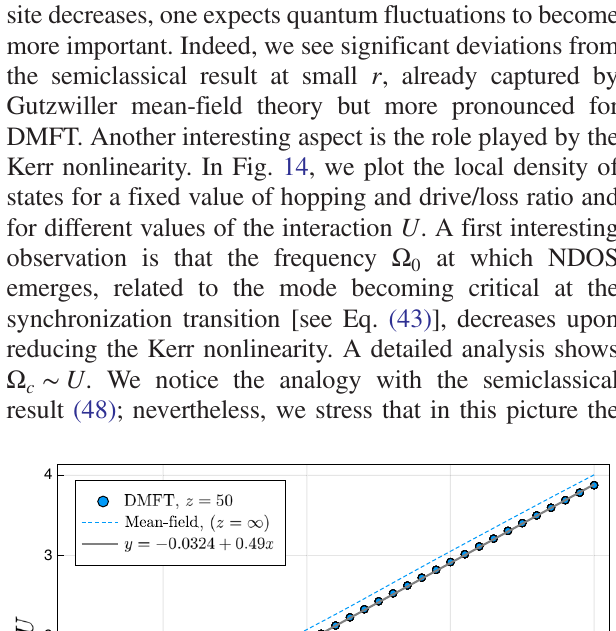
as c =U ∼ r= 2 , in c 14 H ¼